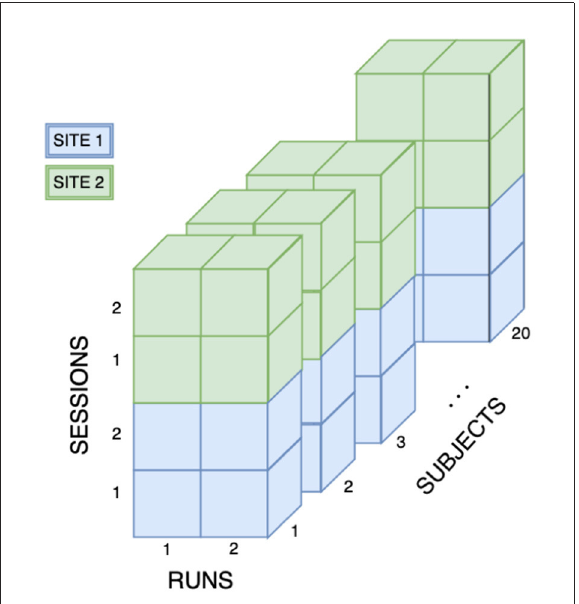
FIGURE1 Overview of the data set. The cohort consists of 20 healthy subjects. All subjects were scanned on Siemens MAGNETOM Prisma (Siemens Healthcare, Erlangen, Germany) located at two different sites. Each subject underwent two sessions on each scanner and had two scans acquired per session, for a total of 160